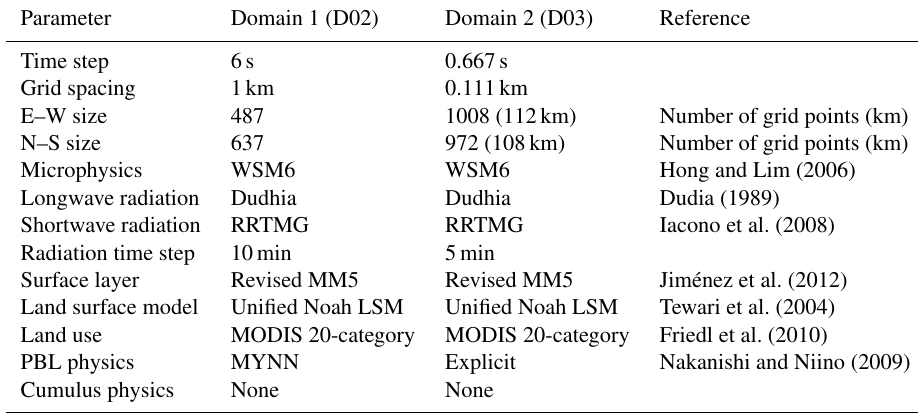
Table 1. Model configuration.